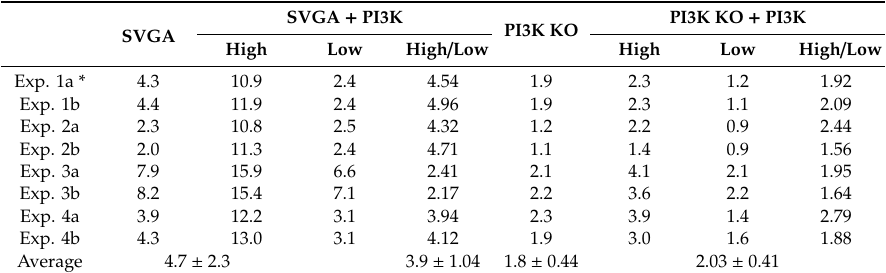
Table 1. Percentage of VP1 +